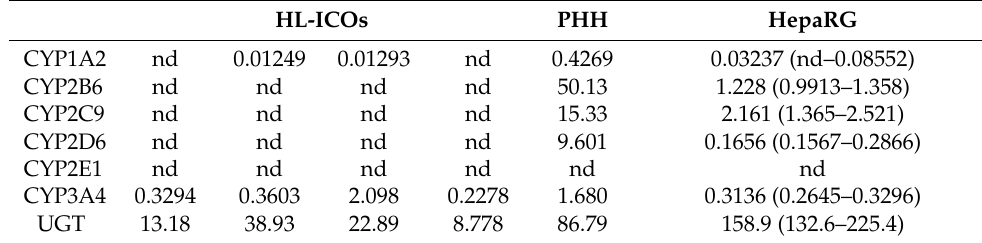
Values presented are the metabolite formation rates (pmol/min/10 6 cells). Hepatocyte-like ICOs (HL-ICOs; differentiation day 12): values are calculated per donor. PHH: Value represents the mean of a technical triplicate. HepaRG: Value represents median of three independent experiments, minimum and maximum formation rate within brackets. nd: not determinable (i.e., no metabolite